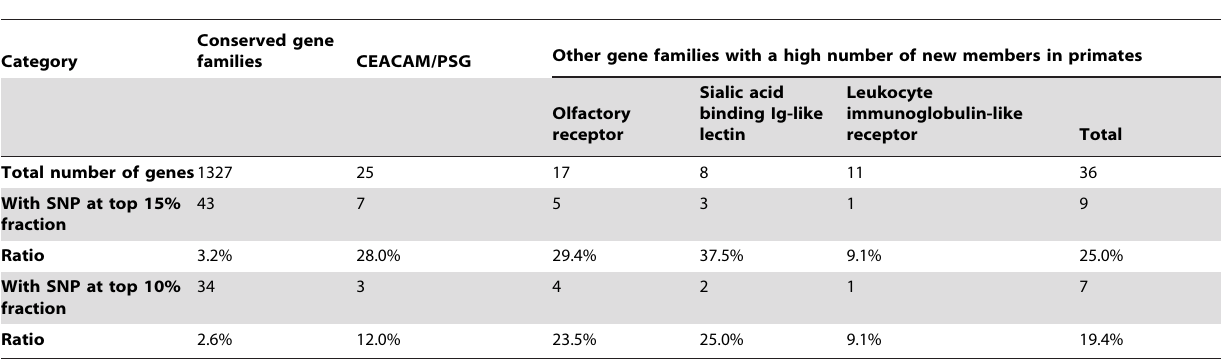
Table 3. Percentage of genes with nonsynonymous SNP(s) that exhibit a high F ST score (in the top 15% or 10% bracket).